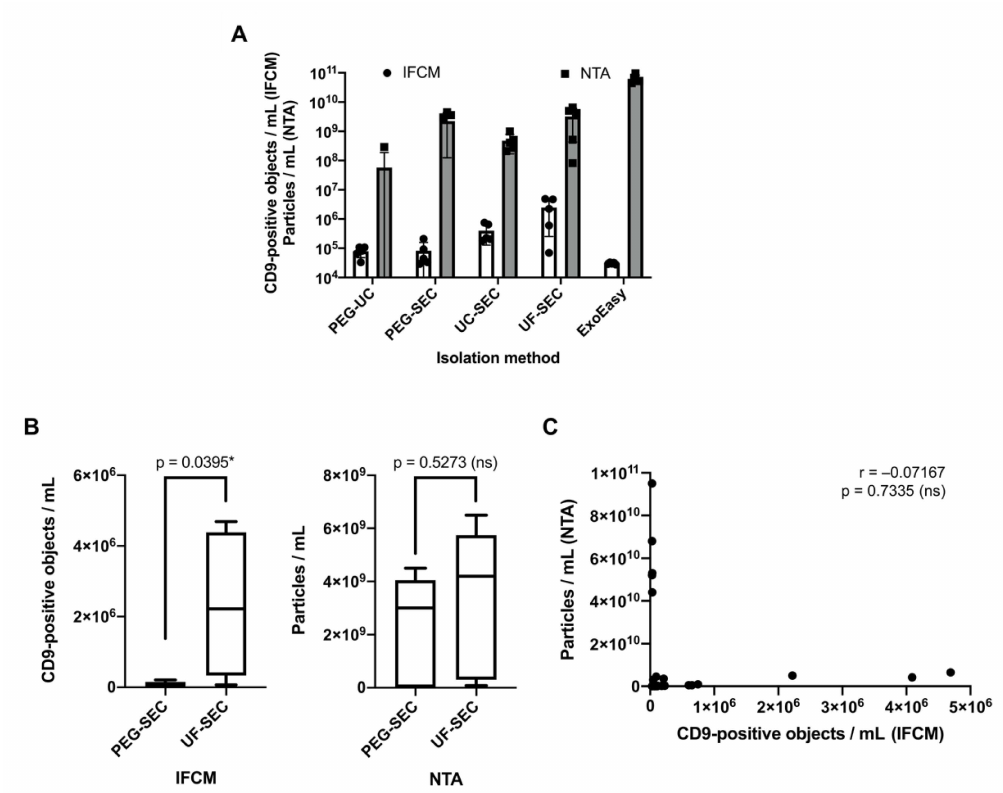
Figure 4. CD9 + object recovery rates evaluated by IFCM are incongruent to particle recovery rates evaluated by NTA. Following processing of five void urine samples with the methods shown in Figure 3, obtained samples were analyzed for the presence of CD9 + objects by IFCM and for the presence of particles by NTA. ( A ) Side-by-side comparison of average numbers of CD9 + objects detected by IFCM and average particle numbers as quantified by NTA. ( B ) Side-by-side comparison of average CD9 + object numbers (left) and average particle numbers (right) detected in UF-SEC and PEG-SEC samples (same data as shown in ( A )). Statistical analysis was performed using Student’s t -test. ( C ) Incongruencies of IFCM and NTA measurements as demonstrated by Spearman’s correlation analysis of all recorded IFCM and NTA data (n = 25). * p ≤